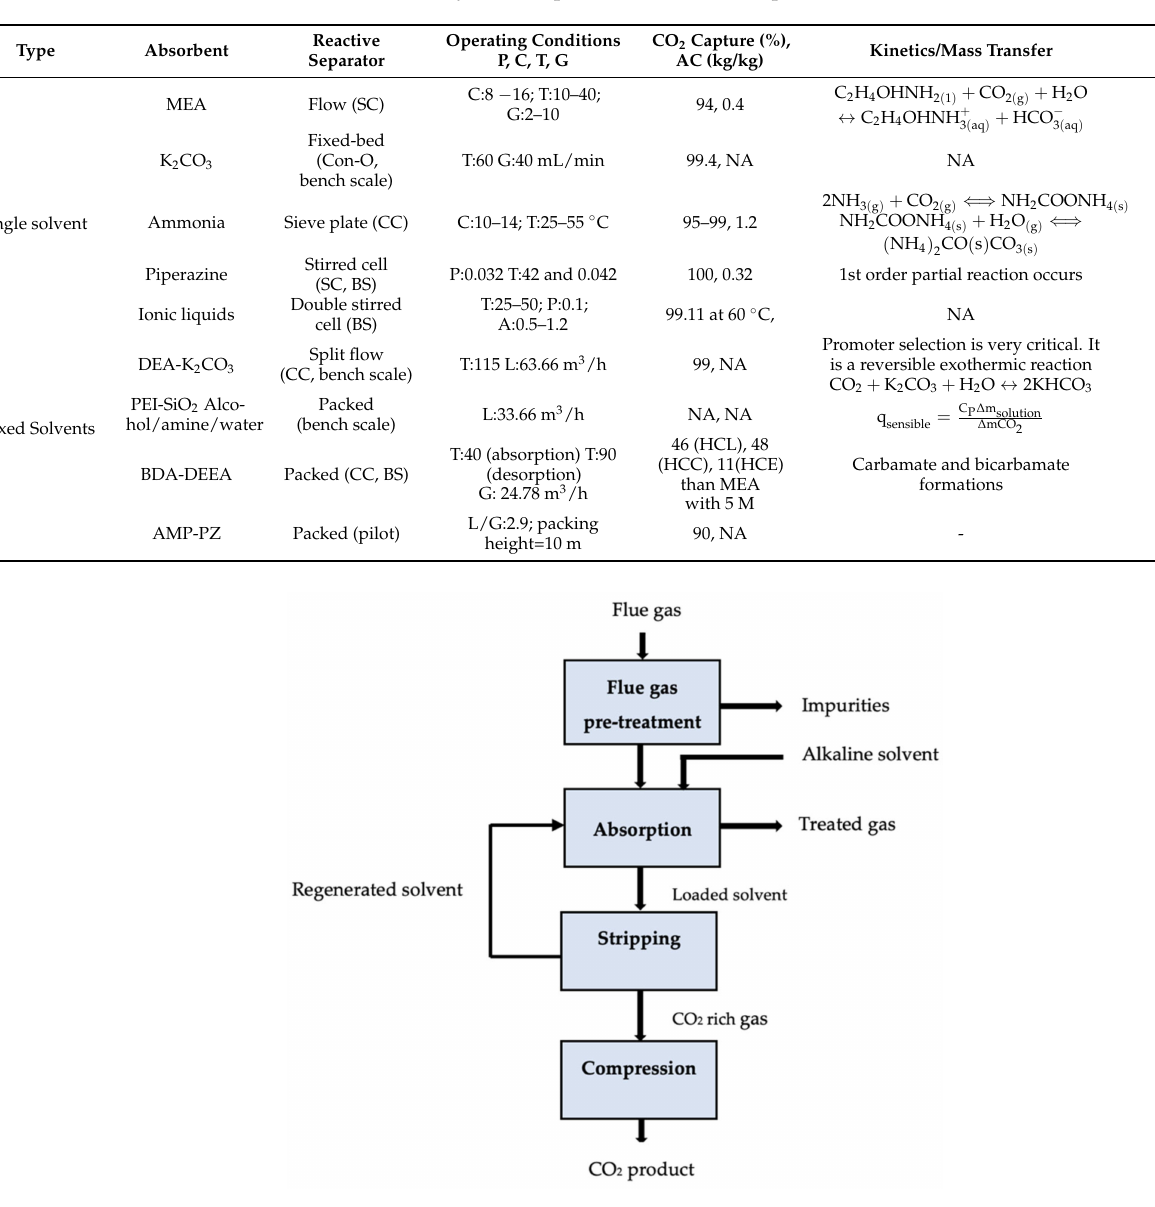
Figure 3. Schematic of an absorption carbon capture process